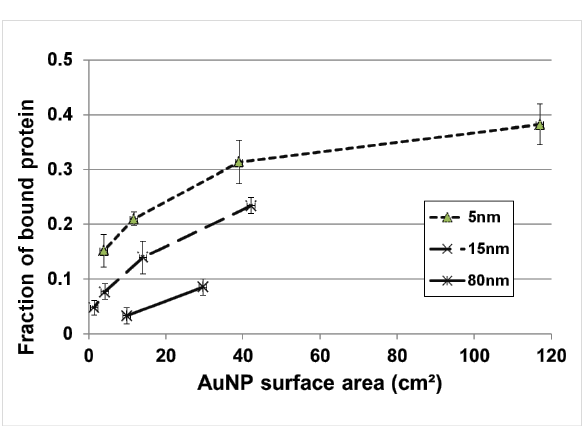
Figure 3: After 24 h incubation the fraction of totally available proteins binding to the AuNP is shown versus the calculated total surface area of all AuNP (as a sum of the individual surface areas of the single AuNP; mean ± SEM; n = 6). Reproduced with permission from [7]. Copyright 2013 IOP